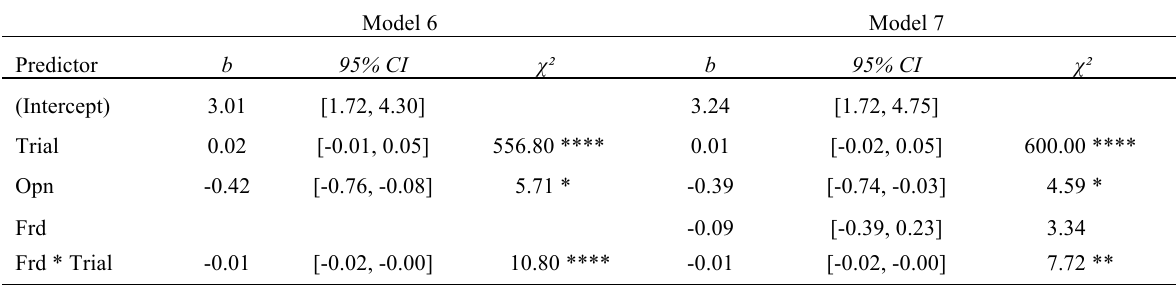
Details of Linear Regression Models of Interest, Predicting Error from Personality Model 6 Model 7 Predictor